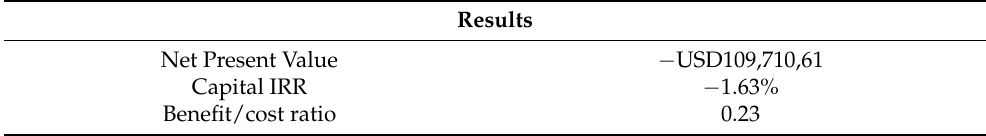
Table 11. Results of the economic